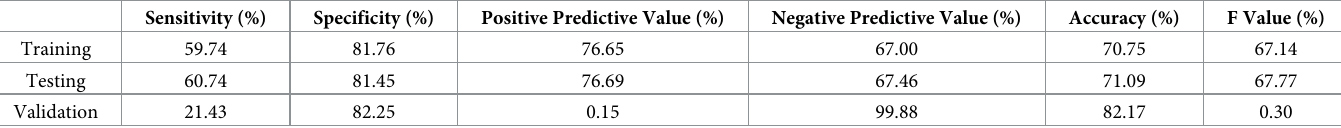
Table 1. Training and testing results